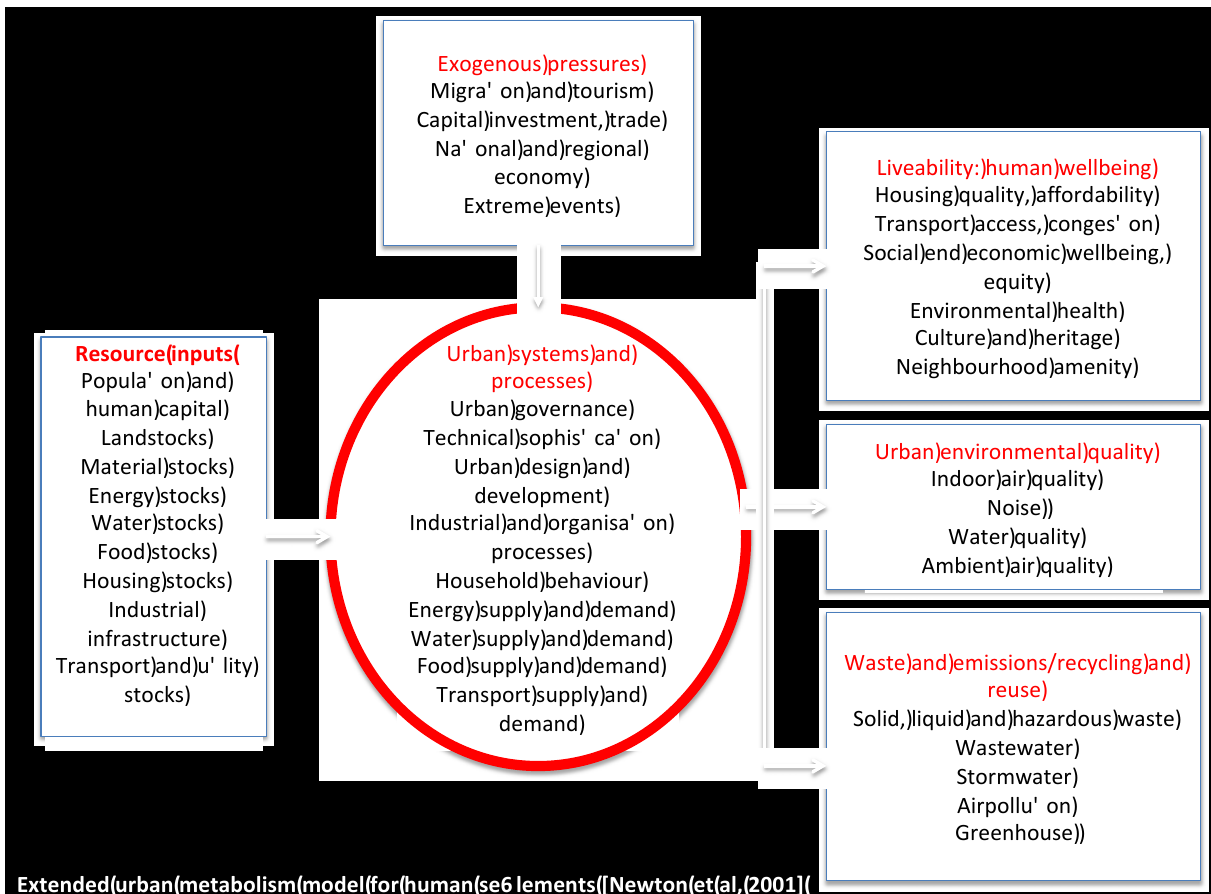
Figure 1. Extended urban metabolism model (adapted from